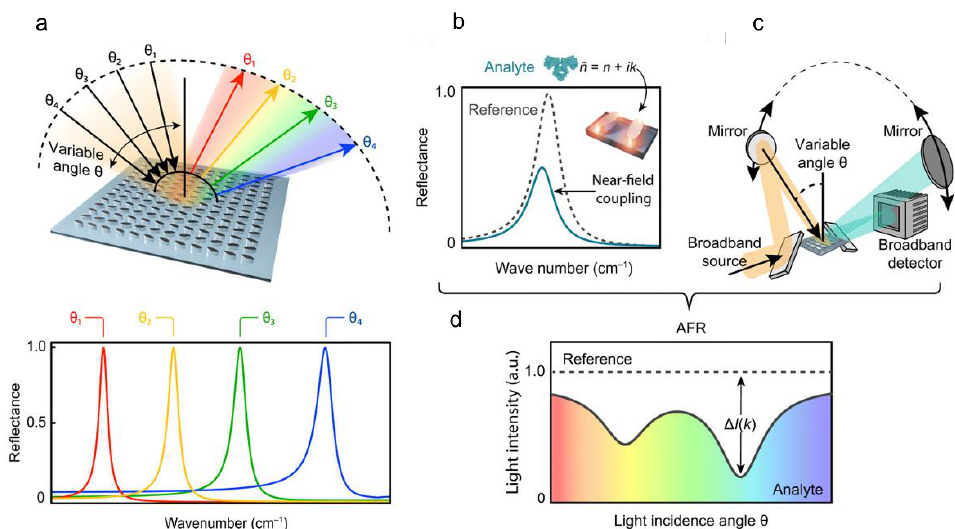
Figure 15. Angle-multiplexed broadband fingerprint retrieval. ( a ) A germanium-based high-Q all-dielectric metasurface delivers on-demand resonances at a specific resonance frequency n for every incidence angle q with broad spectral coverage. Continuous scanning of the incident angle produces a multitude of resonances over a target fingerprint range, realising an angle-multiplexed configuration ideally suited for surface-enhanced mid-IR molecular absorption spectroscopy. ( b ) Strong near-field coupling between the dielectric resonators and the molecular vibrations of the analyte induces an apparent attenuation of the resonance lineshape correlated with the vibrational absorption bands. ( c ) Angle multiplexing combined with the spectral selectivity of high-Q resonances allows for broadband operation and straightforward device implementation. ( d ) The chemically specific output signal of the device scheme in ( c ), which is determined by the imaginary part k of the analyte’s complex